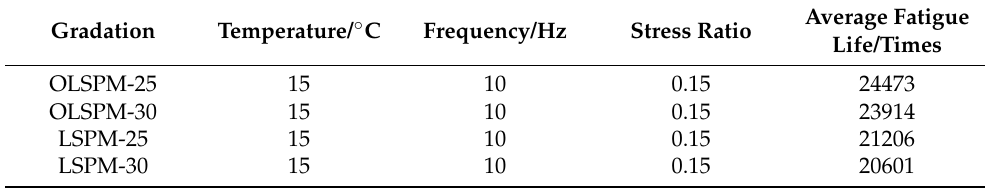
Table 7. Fatigue test results of repeated bending